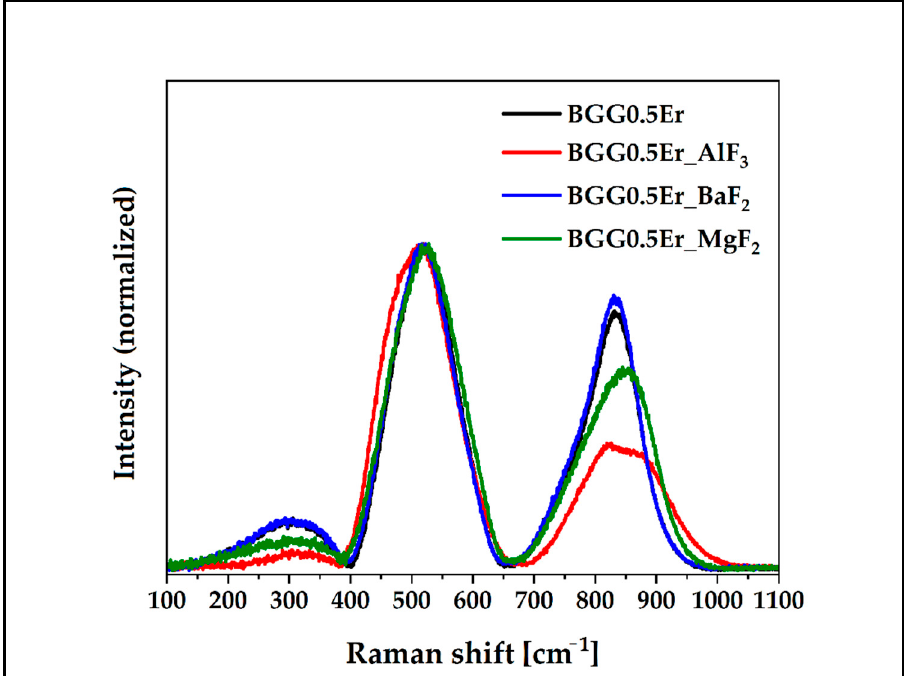
Figure 9. Normalized Raman spectra of glasses in the 100 cm − 1 –1100 cm − 1 range.